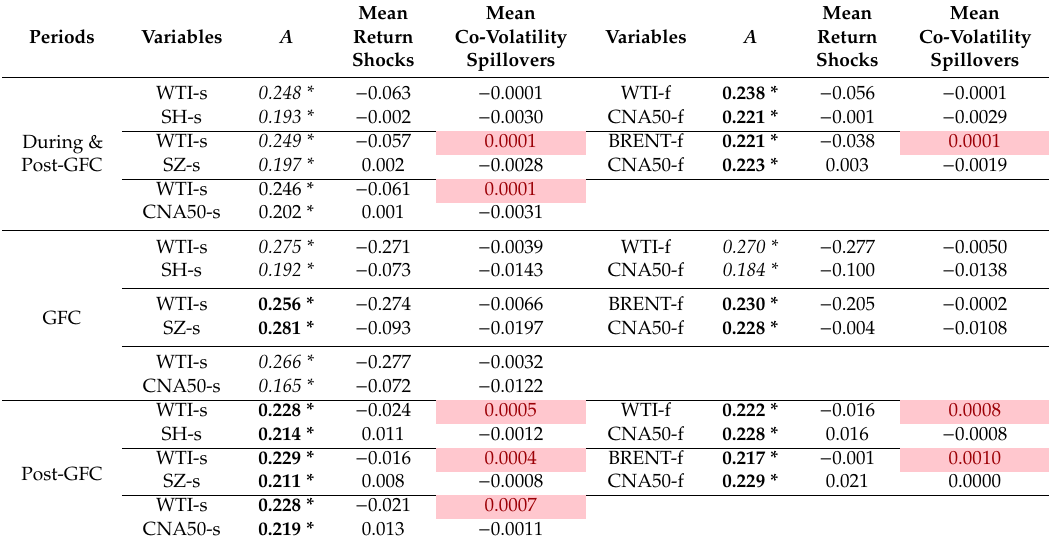
Table 11. Matrix A in Diagonal BEKK, mean return shocks, and mean co-volatility spillovers for the UK and US crude oil markets and Chinese financial markets, three periods (2 × 2).